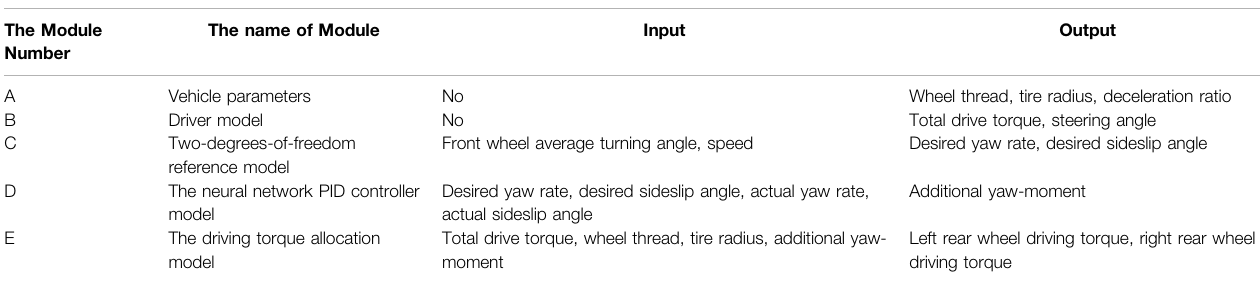
TABLE 2 | Name, input and output of each